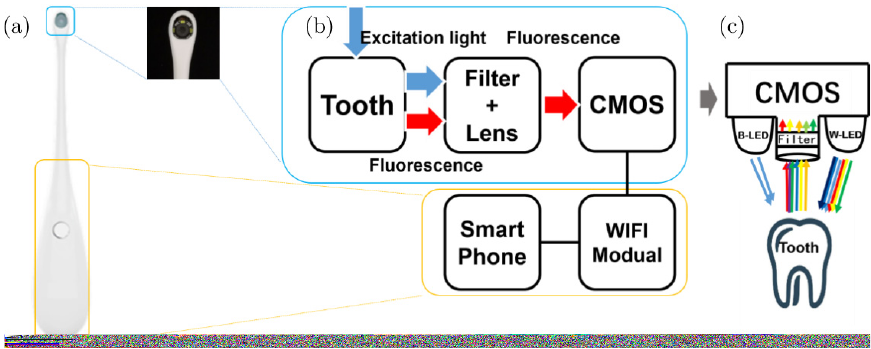
Fig. 1. Schematic diagram of the smart dental detector. (a) The photograph of the imaging system, (b) schematic of the imaging system, (c) schematic of the optical